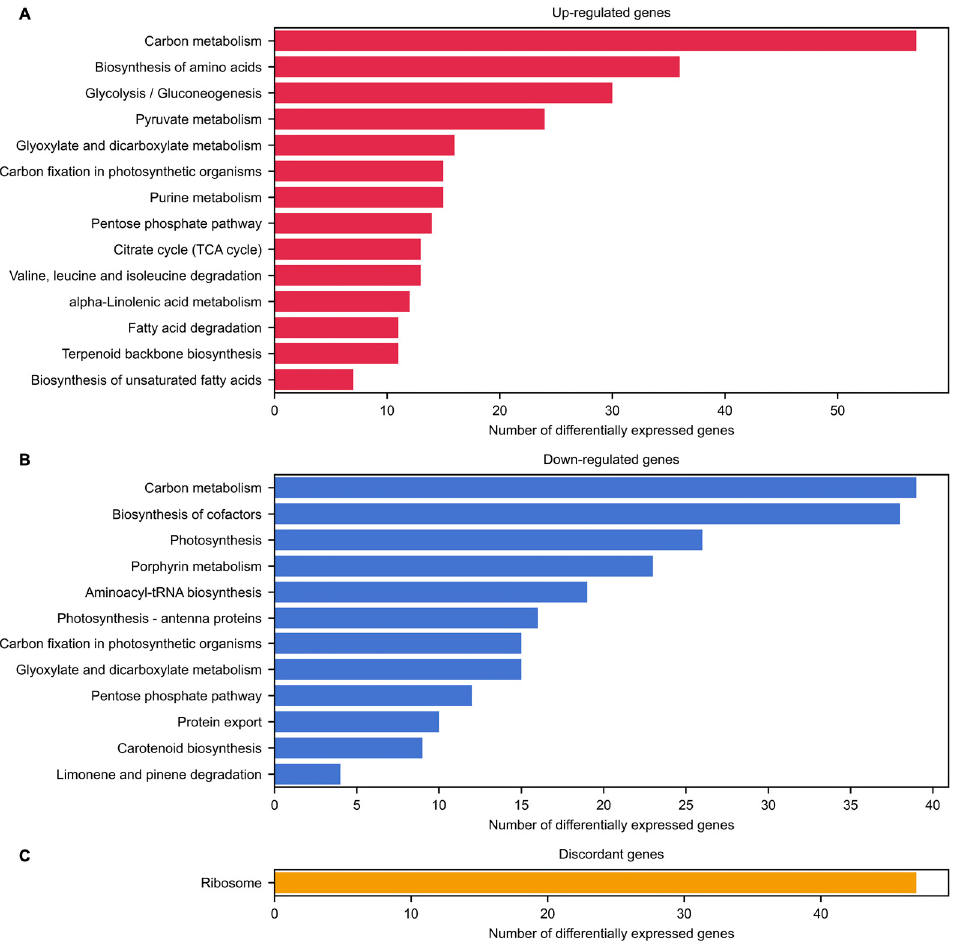
Figure 5. Biological pathways in which differentially expressed genes are involved. The KEGG pathways that are over-represented in each set of differentially expressed genes are the following: common up-regulated ( A ) and down-regulated ( B ) genes, and discordant genes ( C ), in the inflorescence meristem (IM) with respect to the vegetative meristem (VM) in PHA1037 and PHA0595. Details of this pathway annotation can be found in Tables S15–S17.